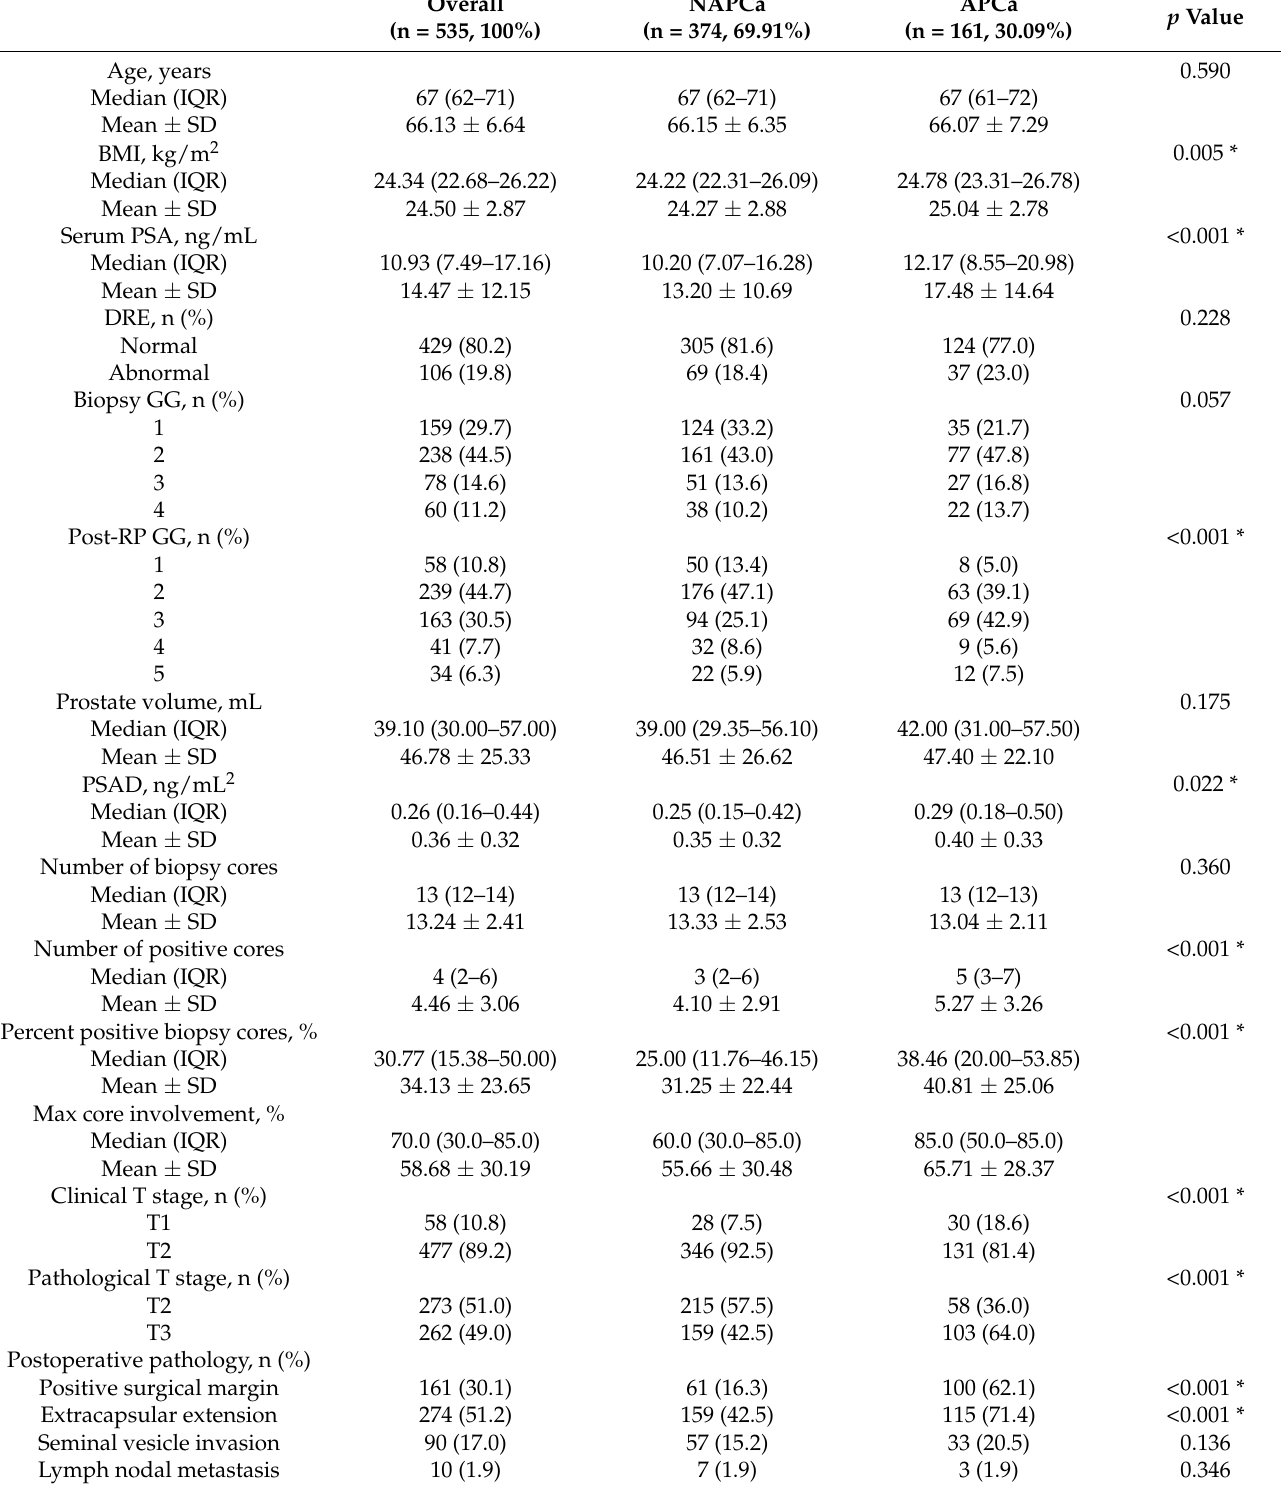
Table 1. Baseline characteristics of the study